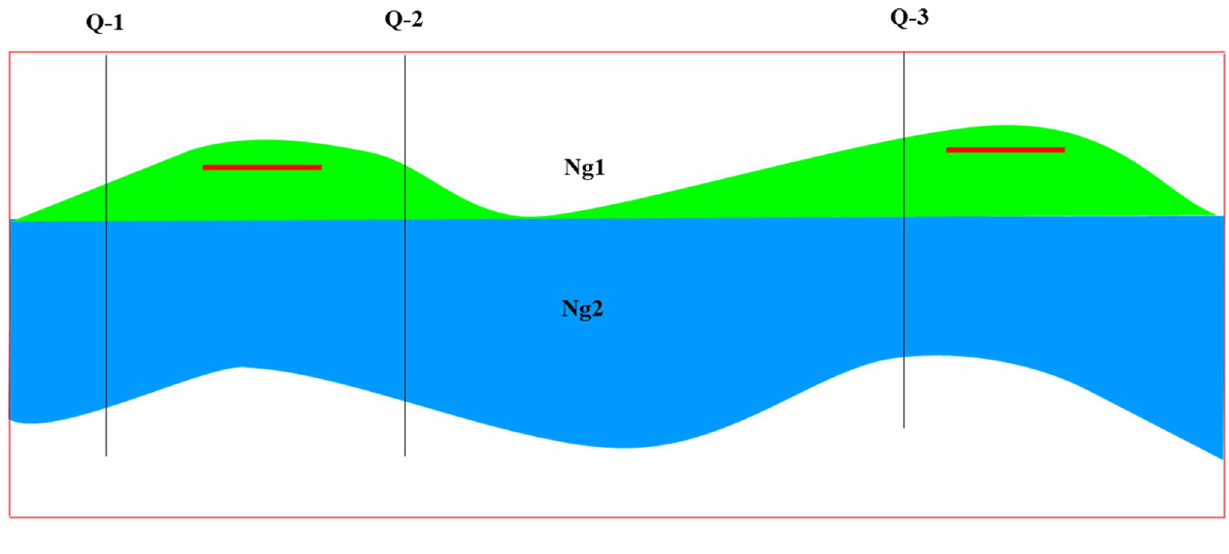
Fig. 1 The reservoir profile map of Q oilfield